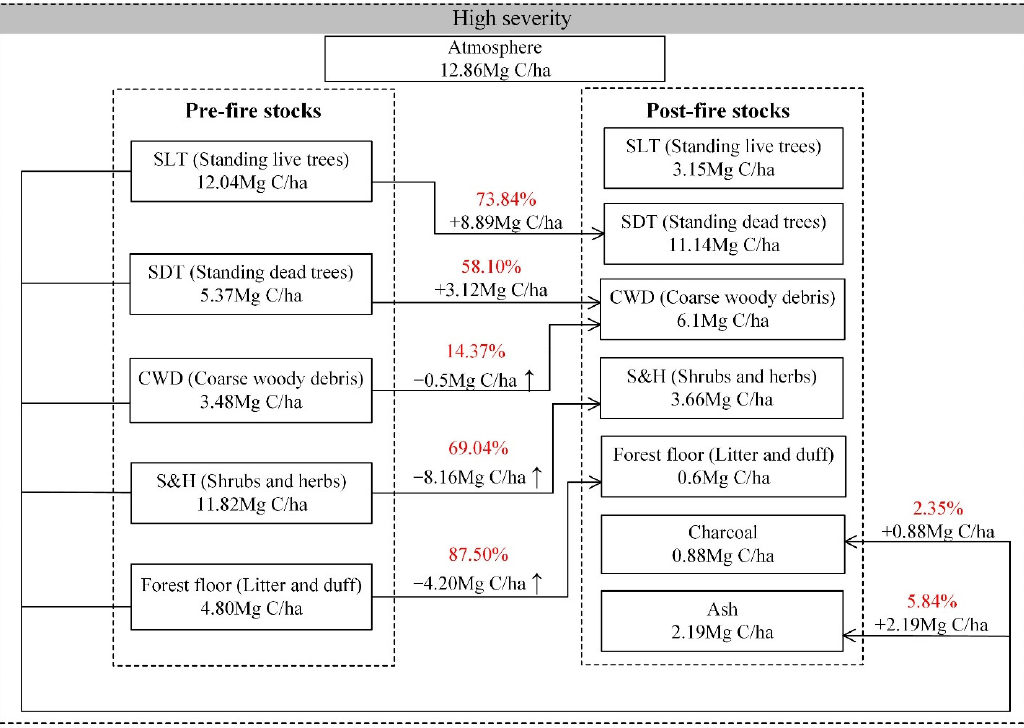
Figure 7. Carbon emissions, transfers, and ratios of changes for each aboveground carbon pool un- der high-severity